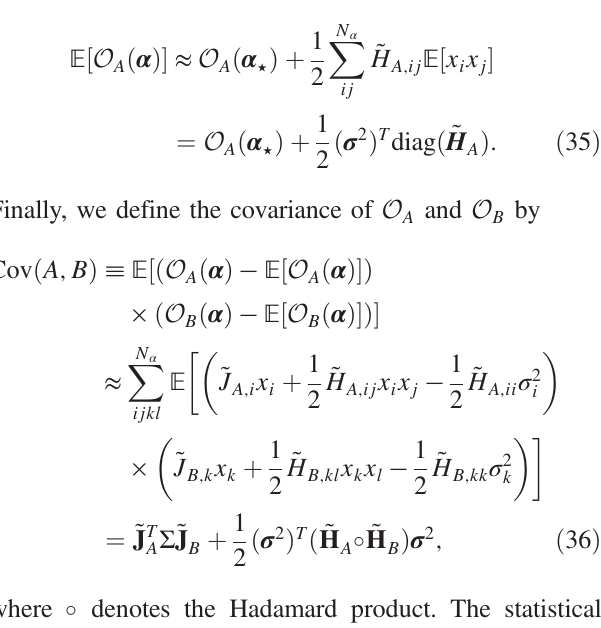
TABLE III. Comparison of different minima at various chiral orders. NN -LECs are optimized using only NN scattering data (at NNLO, the π N LECs are fixed). The minima are equally good for A ¼ 2 observables but differ significantly in A ¼ 3 bound- state properties, calculated here without a three-body force. The last row corresponds to parameters and results (with NN forces only) of the simultaneously optimized NNLOsim interaction. The ~ C LECs are in units of 10 4 GeV − 2 . The scattering χ 2 =N are for data up to 125 MeV without model errors